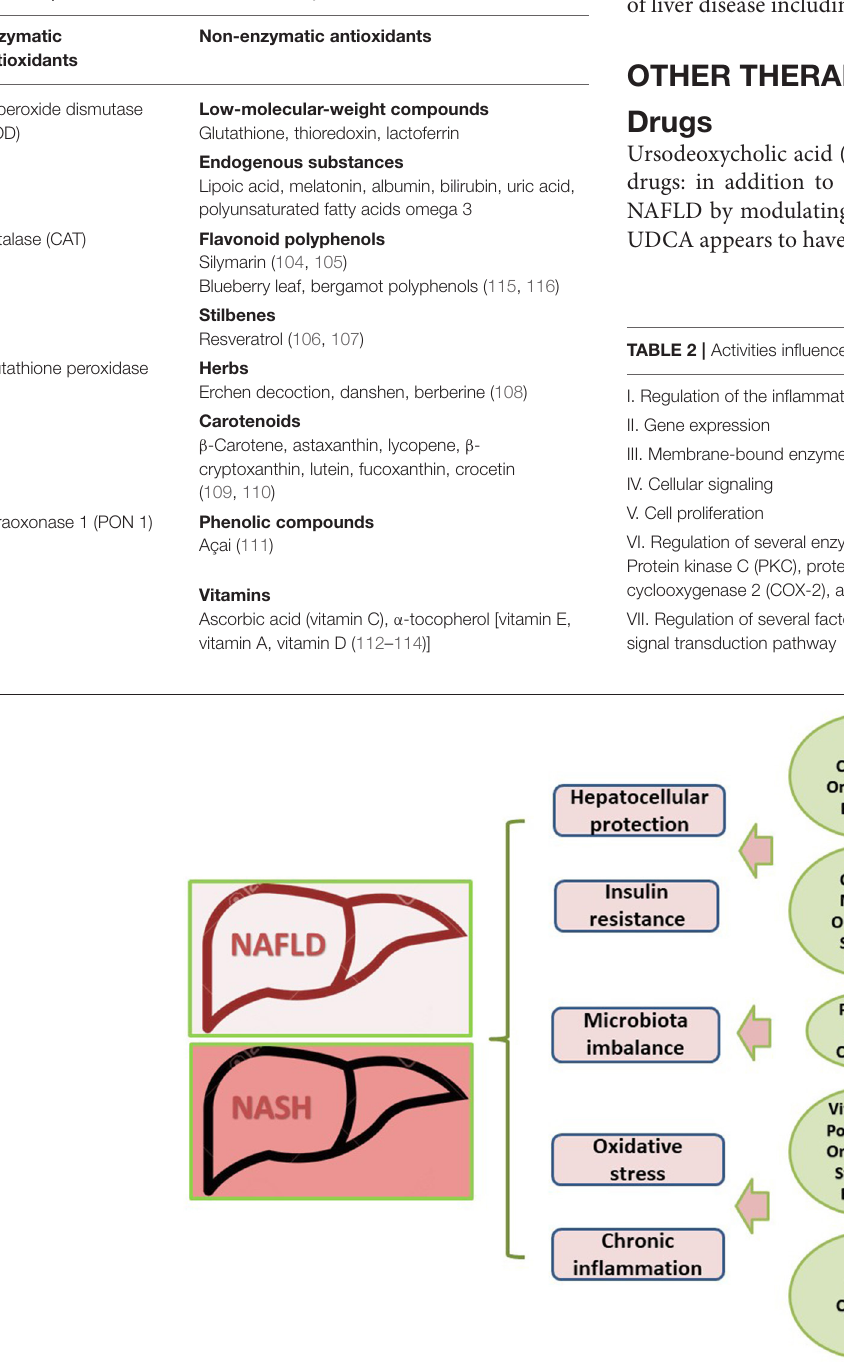
Frontiers in Medicine |